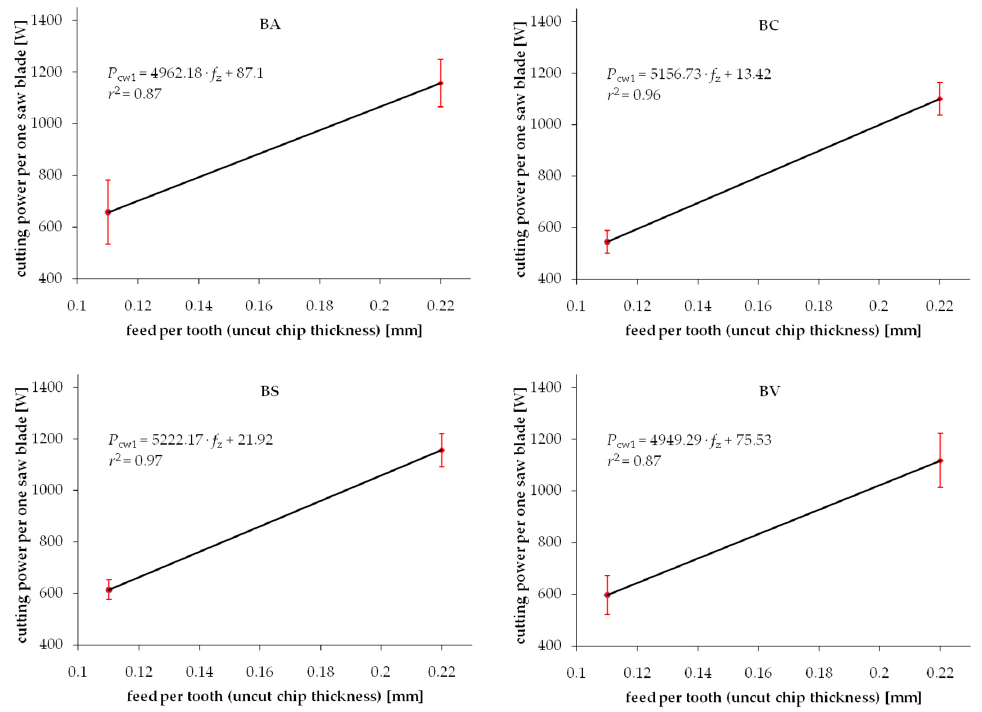
Figure 4. Relation between cutting power per one saw blade and uncut chip thickness when sawing beech wood dried with different methods: BA—air drying, BS—warm heated-steam experimental drying, BC—conventional kiln drying, BV—vacuum kiln drying.